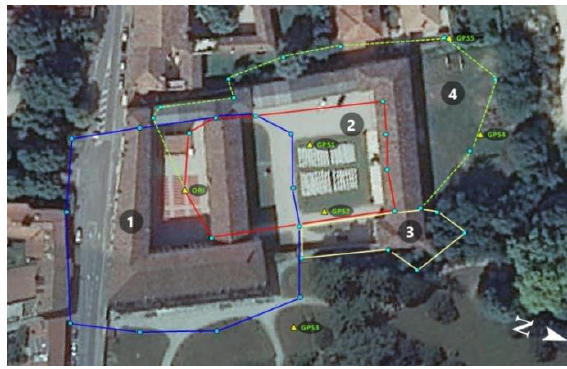
Figure 11: Spatial distribution of the 4 traverses and GCPs